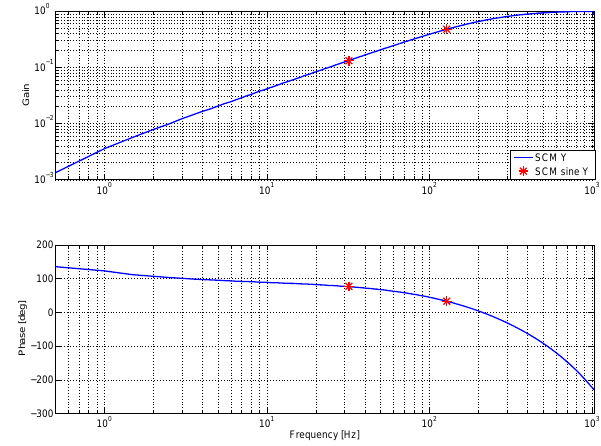
Figure 3. Frequency response of AFG and DFG measured with FFT estimation method and sine signals. FFT length is 4096; overlap is 1023; rectangular window; data duration of 5min.